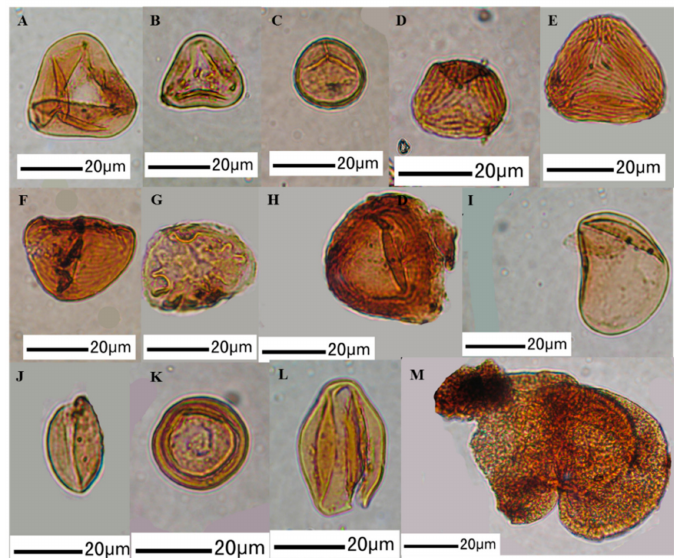
Figure 5. Sporomorphs of the coal samples ( A – H ) are from the No. 3 coal sample; ( I ) is from No.5 coal sample; ( J – K ) are from the No. 8 coal sample; ( L ) and ( M ) are from the No. 10 and 12 coal samples, respectively: ( A ) Cyathidites minor ; ( B ) Gleicheniidites senoicus ; ( C ) Leptolepidites psarosus ; ( D ) Cicatricosisporites minor ; ( E ) Cictricosisporites australiensis ; ( F ) Cicatricosisporites amalocostriatus ; ( G ) Kuylisporites lunaris ; ( H ) Bayanhuasporites membranceus ; ( I ) Laevigatosporites ovatus ; ( J ) Cycadopites acerrimus ; ( K ) Classopollisannulatus ; ( L ) Eucommiidites troedsoni ; and ( M ) Podocarpidites sp from the No. 12 coal